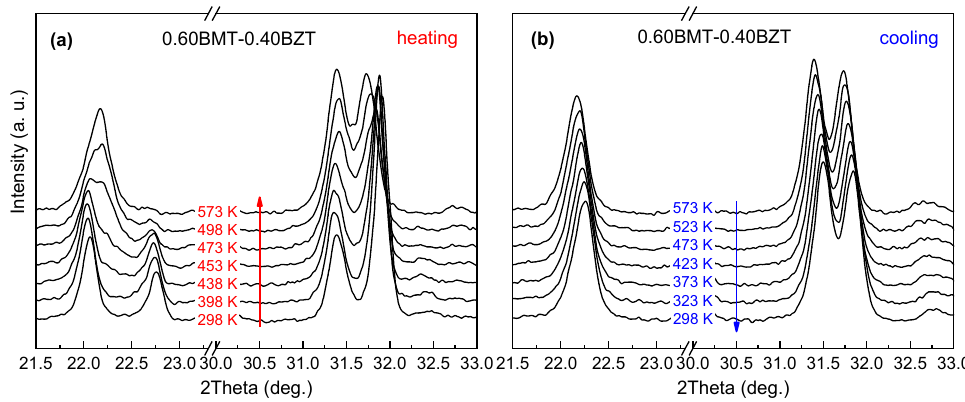
Figure 3. The most representative ranges of the XRD patterns of the as-prepared (1- x )BMT– x BZT sample ( x = 0.40) at the first thermal cycle: ( a ) upon heating to 773 K and ( b ) upon cooling to room temperature. The structural phases at room temperature before and after the annealing are the orthorhombic Pnnm and the tetragonal R 3 c , respectively.